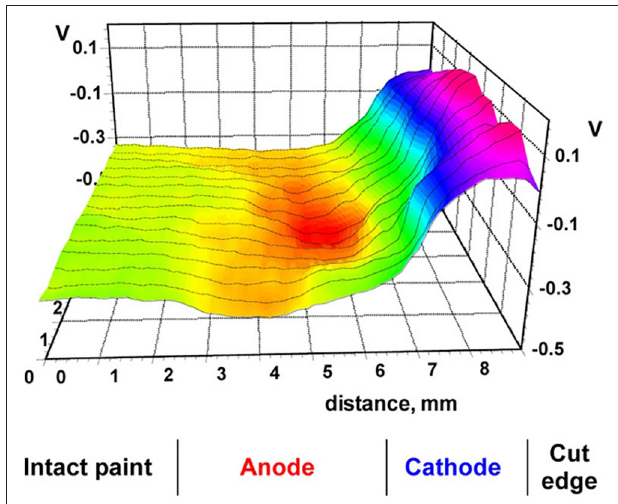
FIGURE 14 | Potential distribution (V vs. SHE) near cut edge for polymer coil coated galvanized steel panel. Reprinted with permission from Elsevier ( Prosek et al.,